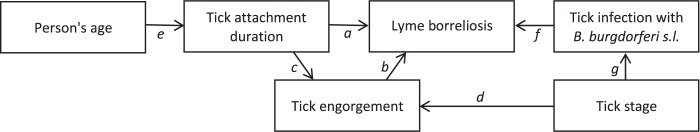
Variables [blocks] and assumed (causal) relations [arrows a to g] between predictors of Lyme borreliosis after a tick bite in the structural equation model.